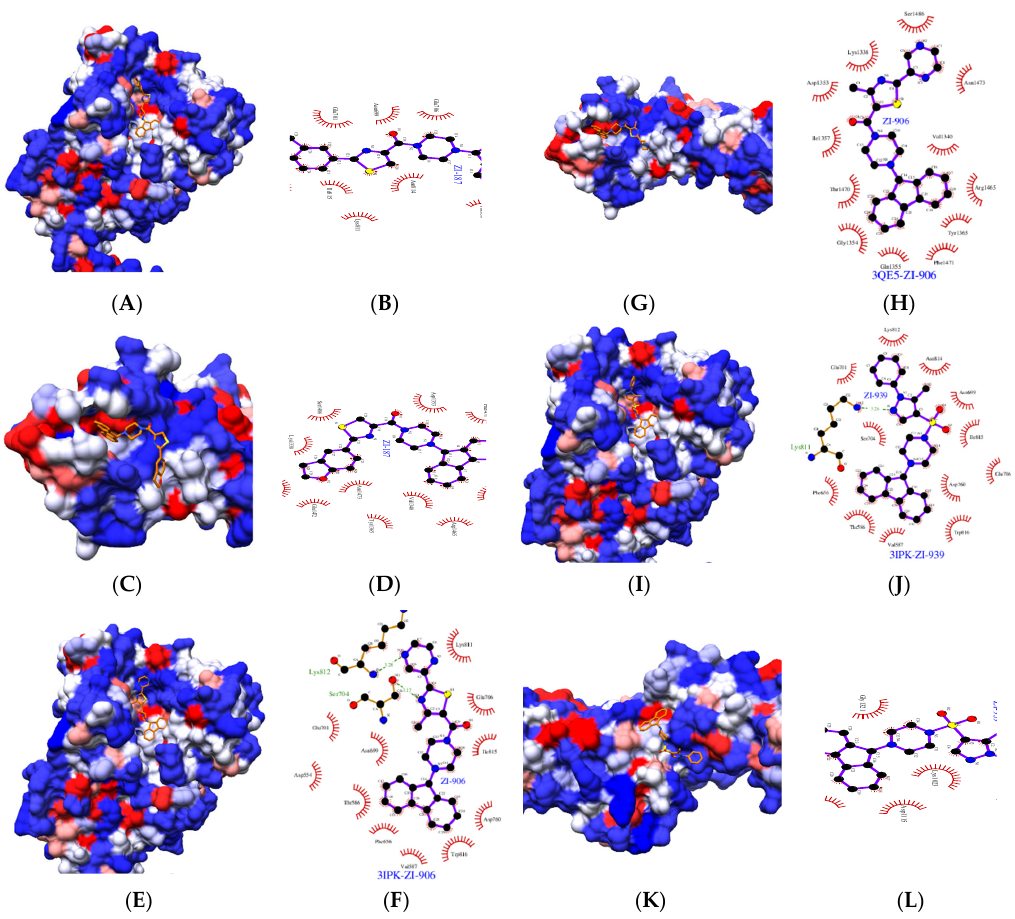
Figure 3. Comparison of the interactions of three molecules with A3VP1 region (PDB: 3IPK) and C-terminal region (PDB: 3QE5) from Ag I/II of S. mutans . Hydrophobicity in surface form is shown for the A3VP1 region interacting with ( A ) ZI-187, ( E ) ZI-906 and ( I ) ZI-939 and C-terminal region interacting with ( C ) ZI-187, ( G ) ZI-906 and ( K ) ZI-939, where the color scale corresponds to that blue is very hydrophilic and red is very hydrophobic. Molecular interactions (to 3 Angstrom radius from the molecules) between residues from A3VP1 region with ( B ) ZI-187, ( F ) ZI-906 and ( J ) ZI-939 and from C-terminal region with ( D ) ZI-187, ( H ) ZI-906 and ( L )